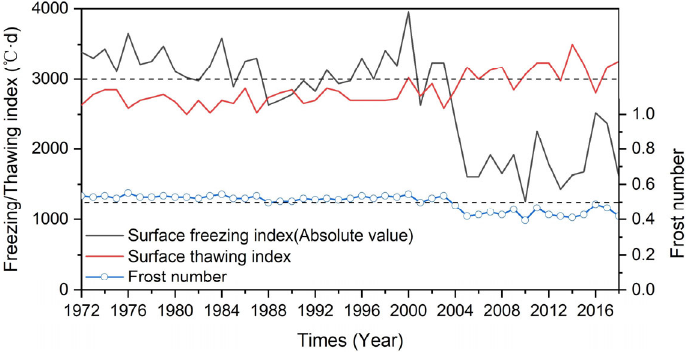
Figure 2. Changes in the surface freezing (thawing) index and surface frost number in the study area from 1972 to 2018.